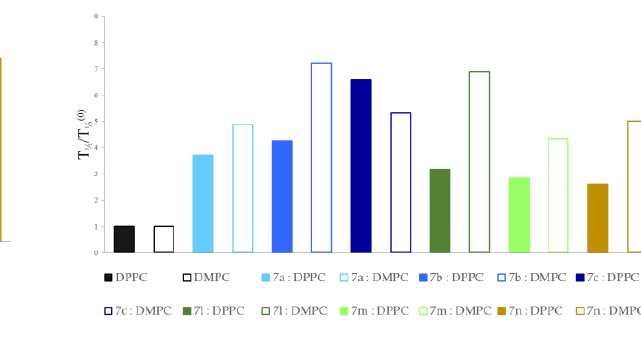
Figure 5. Relative main transition temperature ( a ) and transition peak width at half height ( b ) for 1,2-dipalmitoyl-s n -glycero-3-phosphatidylcholine (DPPC) and 1,2-dimyristoyl-sn-glycero-3-phosphocholine (DMPC) incorporated by compounds studied in 0.1 compound:phospholipid molar ratio.